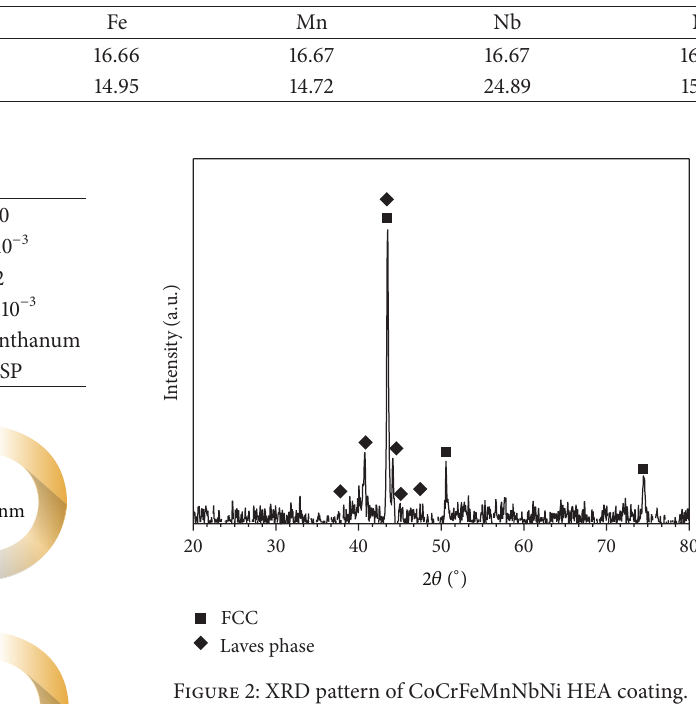
Table 1: Chemical composition of the mixed powder.